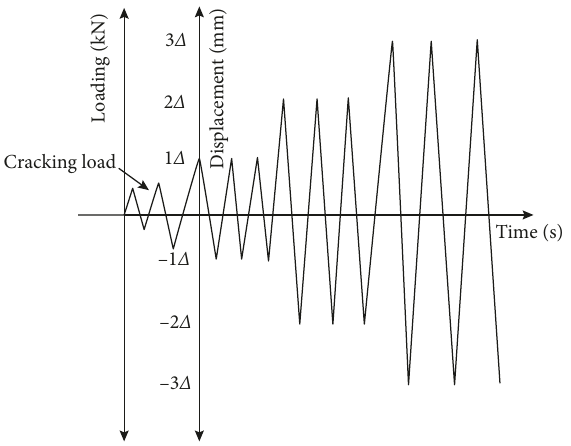
Figure 3: Loading